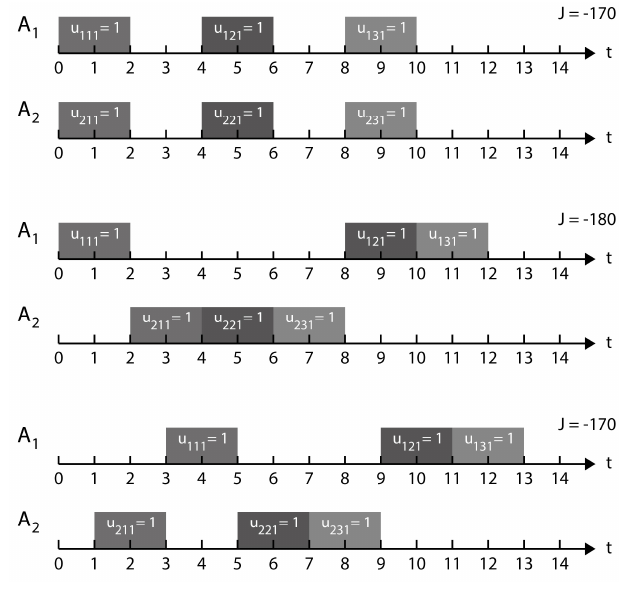
Figure 3. Optimal schedule results.